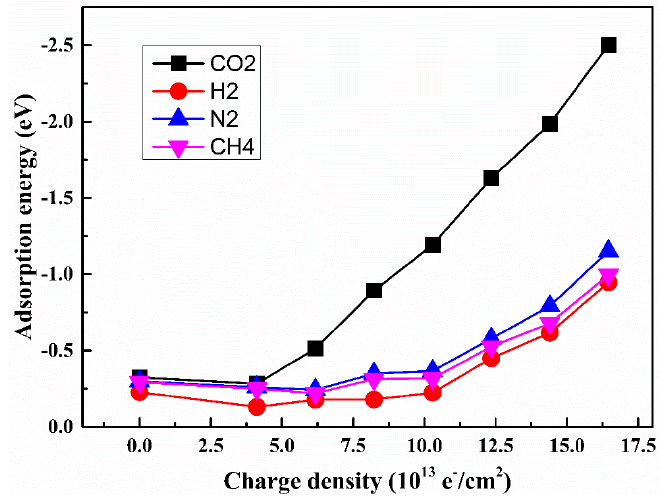
Figure 6. Effect of the injection of negative charges on the adsorption energy of the most stable configurations of SiC 3 nanosheet with CO 2 , H 2 , N 2 and CH 4 adsorption.